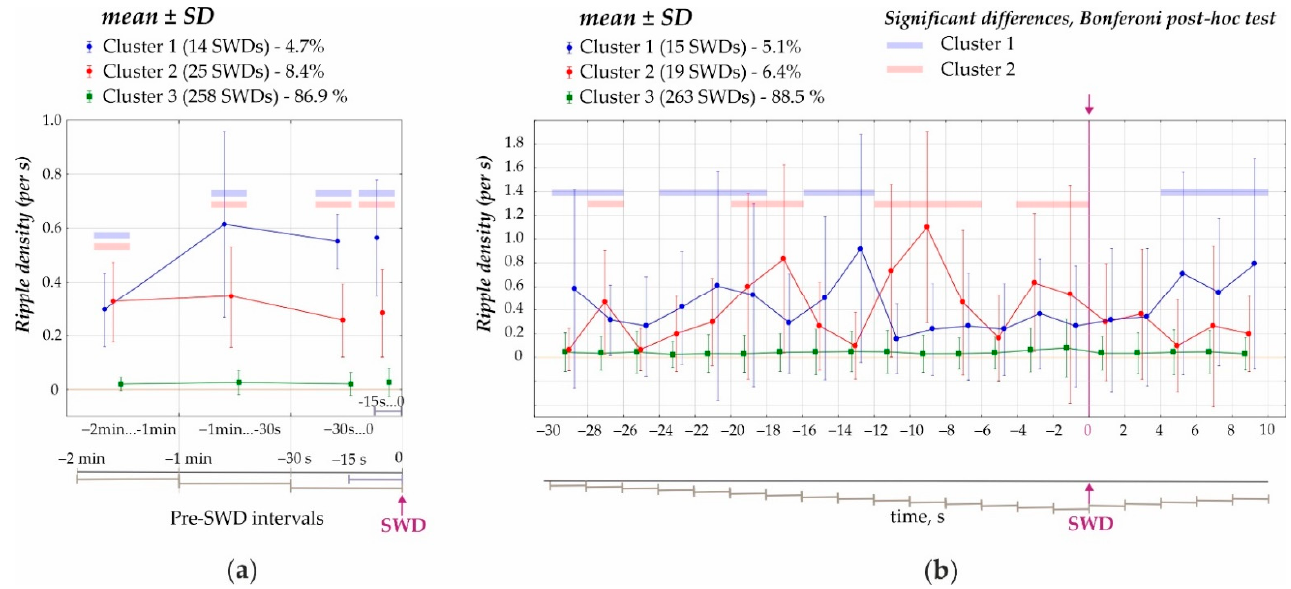
Figure 3. Density of hippocampal ripples before and during SWD. ( a ) Ripple density during the 120 s preictal period divided into three statistically different clusters. Blue and rose stripes highlight significant differences of Cluster 1 (4.7% from all SWDs, shown in blue) and Cluster 2 (8.4%, shown in rose) from Cluster 3 (86.9%, shown in green, all p ’s < 0.0001, Bonferroni tests. ( b ) Ripple density during a 40 s period around the onset of SWDs divided into three statistically different clusters. Blue and rose stripes mark significant differences between Cluster 3 and Cluster 1 (blue) & Cluster 3 and Cluster 2 (rose) (all p ’s <0.05 Bonferroni tests).